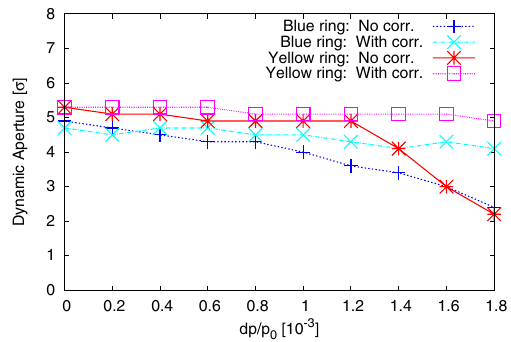
FIG. 6. Comparison of longitudinal bunch profiles between measurement and simulation. There are more particles in satellite buckets from simulation than the measurements.